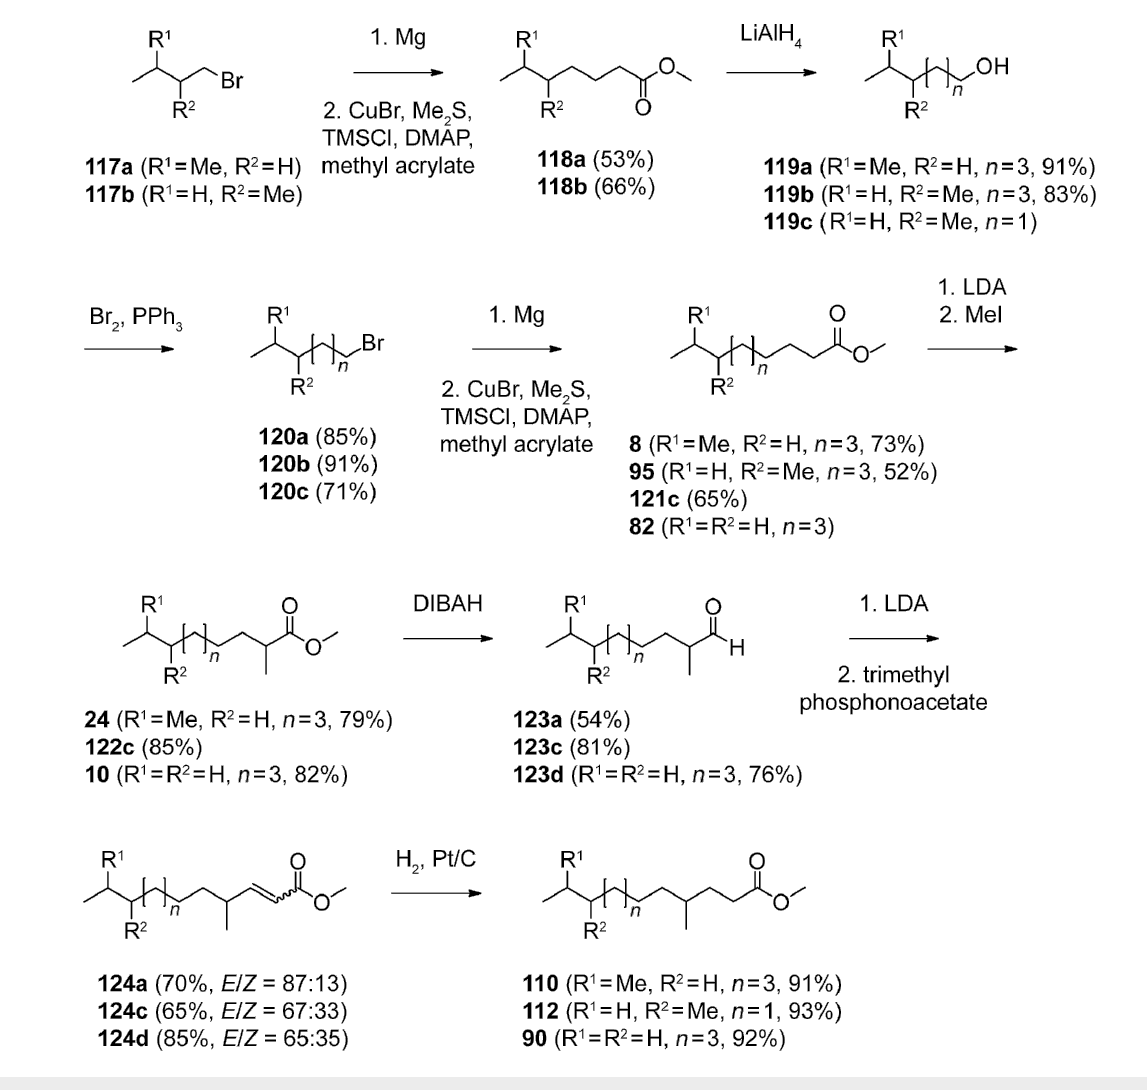
Scheme 3: Synthesis of FAMEs identified from M. aurantiaca